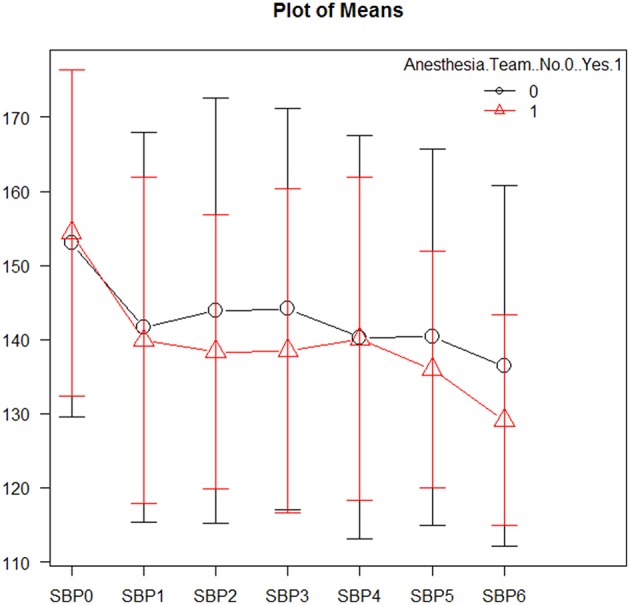
Mean systolic blood pressures during mechanical thrombectomy. Patients in the sedation-trained provider group are represented in black, and patients in the anesthesia team group are represented in red. SBP0 represents systolic blood pressure on arrival to the interventional lab. SBP1-3 are measurements taken prior to revascularization, while SBP4-6 are measurements taken after revascularization.